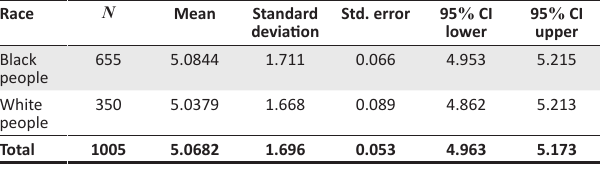
TABLE 4: Descriptive statistics: Leadership effectiveness across race. Race N Mean Standard